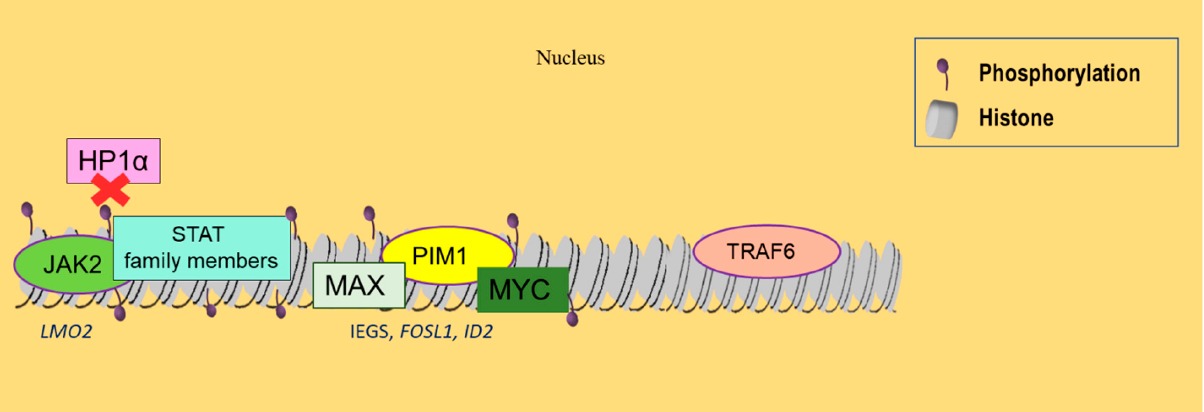
Figure 3. Histone phosphorylation and SUMOylation alterations related to hematological malignancies. JAK2 kinase is commonly activated in MPNs, resulting in histone phosphorylation, which induces the disassembly of HP1 α from chromatin and the activation of LMO2 oncogene. Phosphorylated genes also attract STAT family members, enabling a functional interaction between JAK kinases and STAT proteins. PIM1 kinase, when simultaneously overexpressed with MYC, promotes lymphomagenesis. It can form complexes with MYC and MAX, activating IEGs, FOSL1 , and ID2. Finally, SUMOylation reduces gene expression of the E3 ubiquitin ligase TRAF6 in DLBCL and further represses gene transcription.